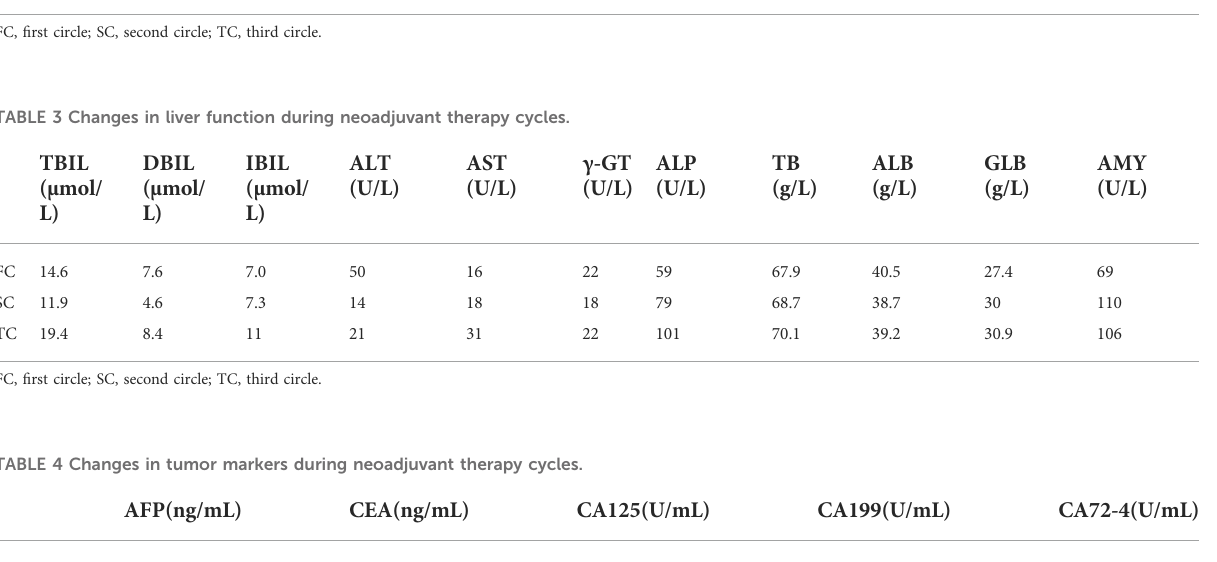
FC, fi rst circle; SC, second circle; TC, third circle.